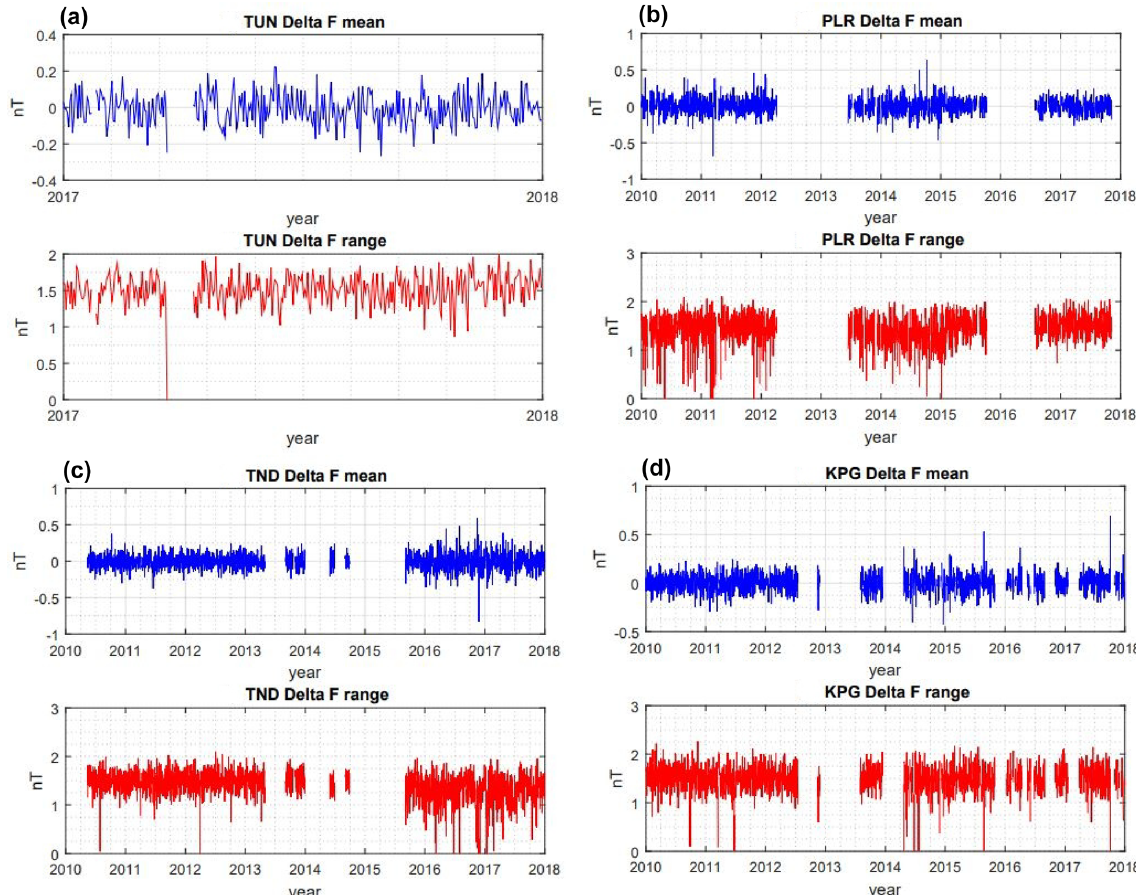
Figure 7. Daily mean (blue lines) and daily range (red lines) of the (cid:49)F plot from four Indonesian observatories. The panels show data from (a) TUN, (b) PLR, (c) TND, and (d)